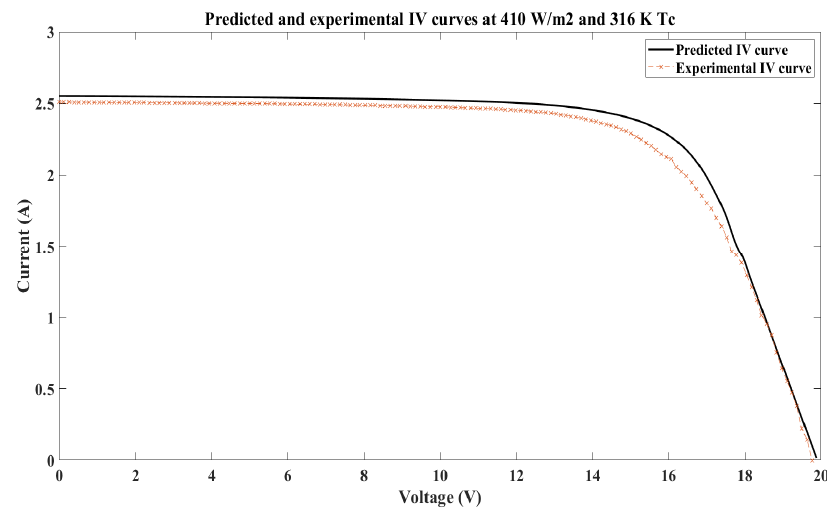
Figure 9. Predicted and experimental IV curves for flexible mono-module at 864 W/m 2 and 314K Tc.